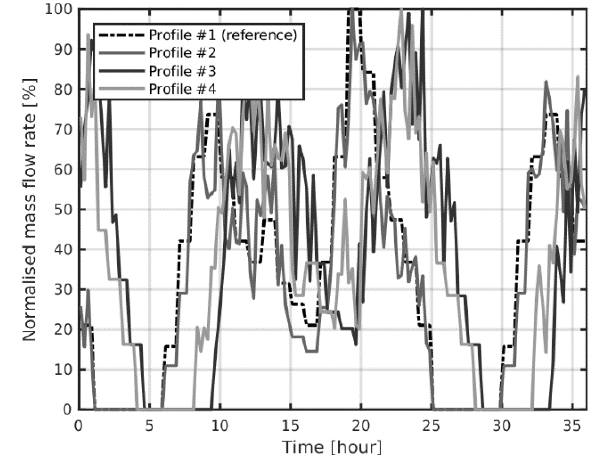
Figure 1. Normalised DHW mass flow rate